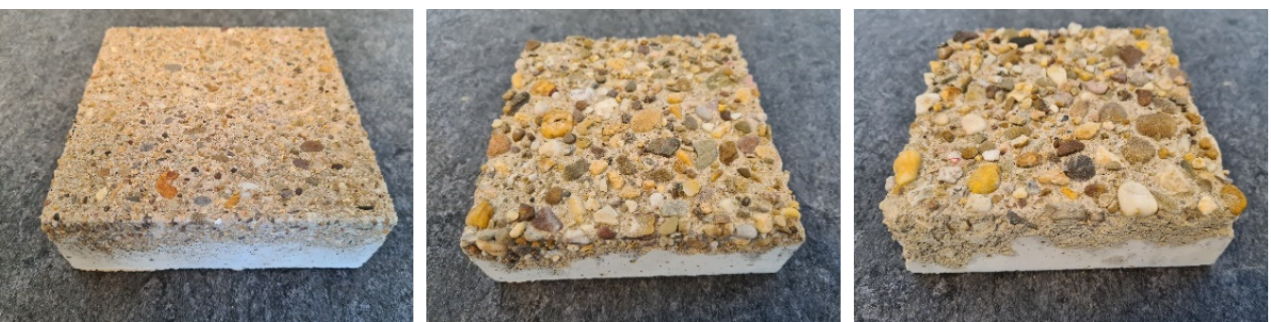
Figure 5. Overview of the three concrete specimens used as investigation objects for accuracy evaluation—to the left specimen 1 with 1.5 mm washout depth, in the center specimen 2 with 3.0 mm washout depth and to the right specimen 3 with 6.0 mm washout depth. Table 1. Specifications of the three concrete specimens used as investigation objects for accuracy evaluation. Concrete